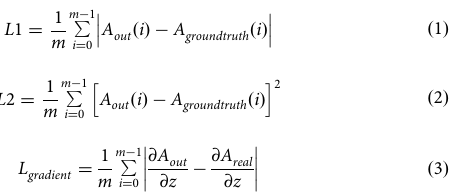
rabbit abdominal aortas with atherosclerotic plaque (a male New Zealand white rabbit weighting ~3 – 3.5 kg, n = 1, DooYeol Biotech, Korea). Note that the OCT images helically scanned in polar coordinates were provided as inputs of the models, and the output images after the deep learning process were subjected to Cartesian transformation for visualization. All animal experiments were approved by the Institutional Animal Care and Use Committee of Korea University (KOREA-2019-0152-C1, KOREA-2021-0076) and were performed in accordance with national and institutional guidelines. Preparation of training datasets for NetA . Training datasets for each model were separately generated by directly processing the raw interference fringes. The input and ground truth of the dataset for NetA were constructed by pairing OCT A-scans and interferograms with degraded axial resolution and the currently optimized OCT A-scans, respectively. Here, the currently optimized OCT A-scans are the A-scans with the best axial resolution achievable using our OCT system, which applies the best post-processing methods including background removal, k-line- arization, and numerical dispersion compensation 7 . On the other hand, the input was processed by applying imperfect numerical dispersion compensation and bandwidth truncation. Imperfect compensation in terms of dispersion was applied by randomly adjusting the polynomial fi tting coef fi cients of dispersion, resulting in degraded axial resolution. The degree of degradation has been determined empirically to deteriorate the axial resolution by up to a factor of 2; detailed procedures can be found in the Supplementary Note 2. In addition, the axial resolution is inversely proportional to the bandwidth of the laser 7 . Accordingly, by truncating the bandwidth of the laser source, A-scans with degraded axial reso- lution can be obtained. The degree of bandwidth truncation was randomly selected within 0.5 times by applying Gaussian windows to the raw fringe before applying FFT. Example results of optimal and degraded OCT images, A-scans, and spec- trograms for one of those A-scans are shown in Supplementary Fig. 6. The window and overlap size of the STFT were empirically set at 325 and 275 cm (cid:2) 1 , respectively, to generate a spectrogram with 14 different depth pro fi les derived from different spectral bands. Each piece of data was normalized to improve the training ef fi ciency of a gradient descent algorithm. Speci fi cally, the transform results of STFT and FFT are a log compressed amplitude spectrum with a single precision fl oating point. Therefore, the range of the valid intensity range of the STFT and FFT results was normalized to between -1 and 1, respectively. After preprocessing, to augment the training dataset, two adjacent A-scans were randomly selected in each B-scan and randomly fl ipped in the horizontal direction. Training strategy of NetA . The schematic of NetA architecture is shown in Fig. 6a; details are provided in the Supplementary Note 3, along with Supple- mentary Table 1. In the training phase, the generator receives degraded inter- ferograms and A-scans and learns to generate paired optimal A-scans. Then, the reconstructed A-scans are fed to a discriminator that learns to discriminate between the ground truth A-scans and the generated A-scans, and then returns feedback (0 or 1) to the generator. As the generator and discriminator networks are, alternately, trained, the two networks compete to the theoretical limit at which the generated A-scan and the ground truth cannot be distinguished. The loss functions of the generator and the discriminator were de fi ned as follows. The generator was trained with L1 loss, L2 loss, and gradient loss regarding only the axial direction, each de fi ned as follows: